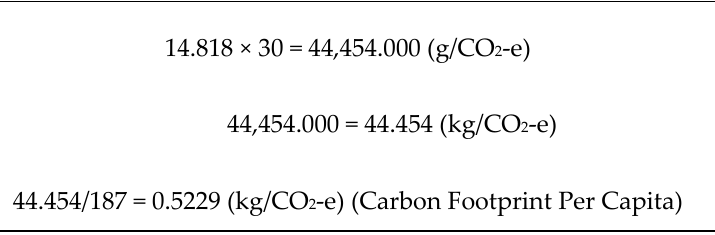
Figure 3. Average per capita carbon footprint for Lithuania .